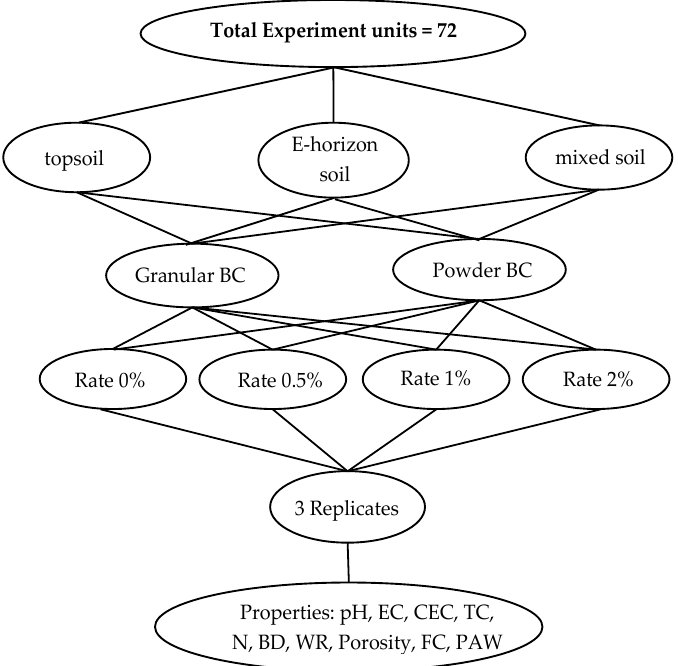
Figure 1. Flow chart of investigating the effect of biochar type and different rates on physicochemical